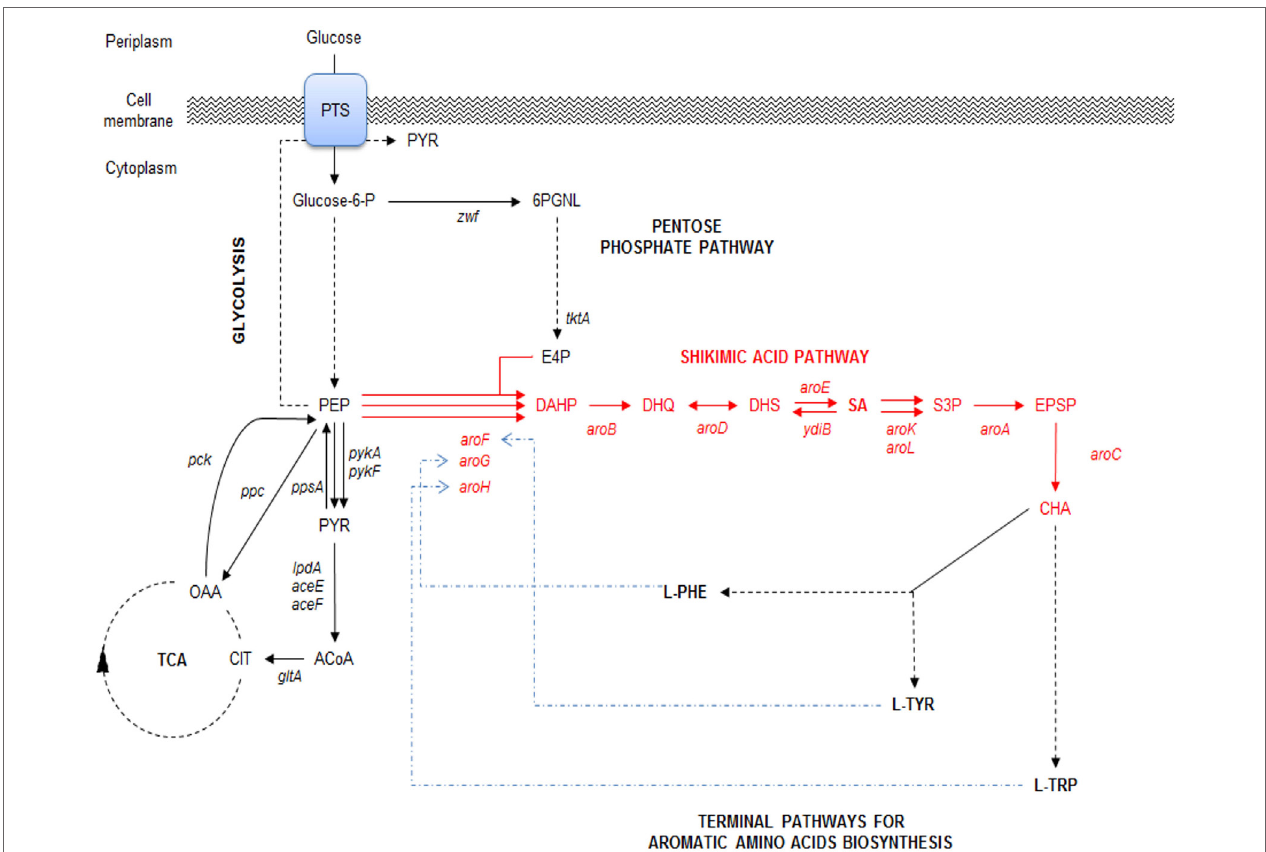
FiGURe 1 | Schematic representation of the main glucose transport system, central carbon metabolism (CCM) (glycolysis and pentose phosphate pathways), their interconnection with SA pathway and final aromatic amino acids pathway in E. coli . PTS, phosphotransferase:PEP:glucose system. CCM key intermediates and protein encoding genes: TCA, tricarboxylic acid pathway; E4P, erythrose-4-P; PGNL, 6-phospho d -glucono-1,5-lactone; PEP, phosphoenolpyruvate; PYR, pyruvate; ACoA, acetyl-CoA; CIT, citrate; OAA, oxaloacetate; zwf , glucose 6-phosphate-1-dehydrogenase; tktA , transketolase I; pykA , pykF , pyruvate kinase II and pyruvate kinase I, respectively; lpdA , aceE , and aceF , coding for PYR dehydrogenase subunits; gltA , citrate synthase; pck , PEP carboxykinase; ppc PEP carboxylase; ppsA , PEP synthetase. SA pathway intermediates and genes: DAHP, 3-deoxy- d - arabino -heptulosonate-7-phosphate; DHQ, 3-dehydroquinate; DHS, 3-dehydroshikimate; SA, shikimic acid; S3, SHK-3-phosphate; EPSP, 5-enolpyruvyl-shikimate 3-phosphate; CHA, chorismate; aroF , aroG , aroH , DAHP synthase AroF, AroG and AroH, respectively; aroB , DHQ synthase; aroD , DHQ dehydratase; aroE and ydiB , SHK dehydrogenase and SHK dehydrogenase/quinate dehydrogenase, respectively; aroA , 3-phosphoshikimate-1-carboxyvinyltransferase; aroC , CHA synthase. Terminal aromatic amino acids products: l -TRP, l -tryptophan; l -PHE, l -phenylalanine; l -TYR, l -tyrosine. Continuous arrows indicate single enzymatic reactions; dashed arrows show several enzymatic reactions; dashed-dotted arrows (blue) show repression of DAHPS isoenzymes allosteric regulatory circuits. Adapted from Keseler et al. (2013) and Rodriguez et al.